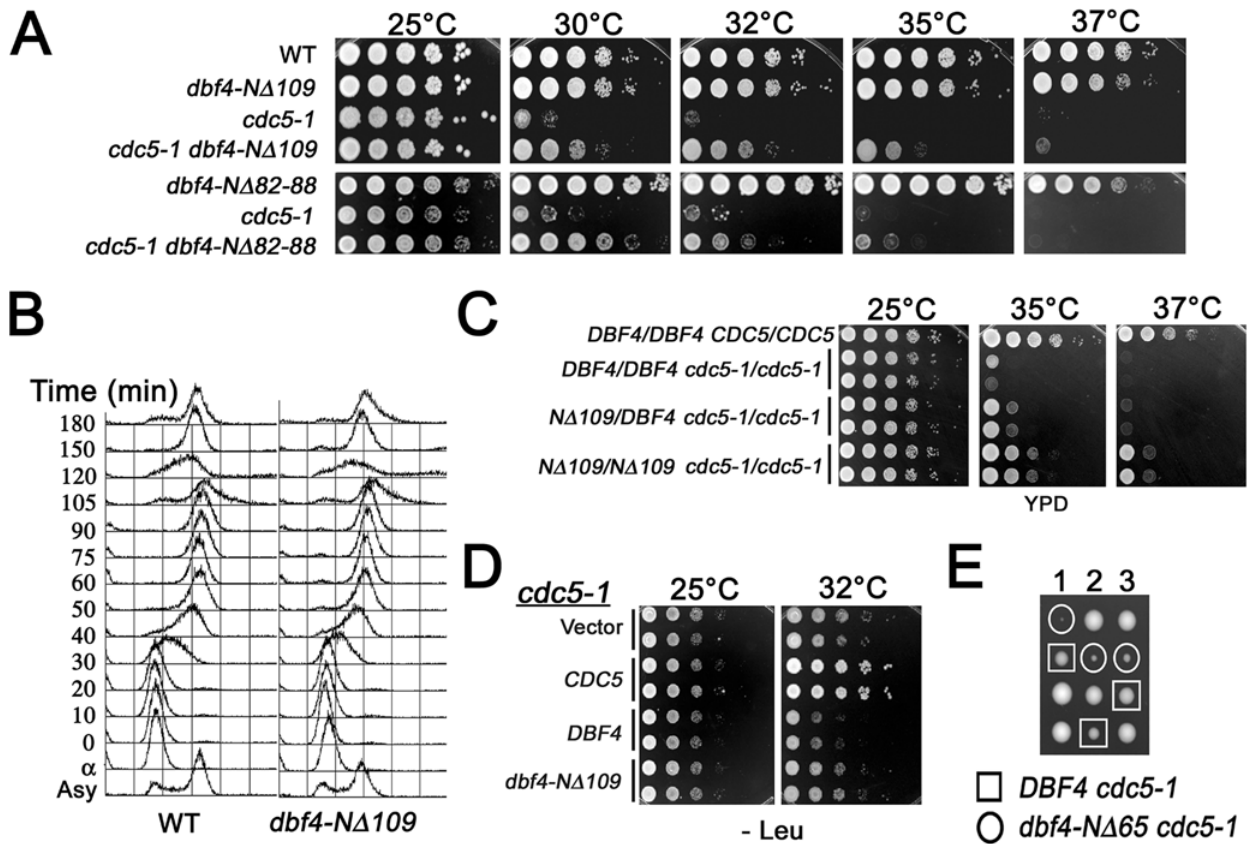
Figure 3. The Dbf4p N-terminus inhibits Polo activity. (A) dbf4-N D 109 rescues the cdc5-1 temperature sensitivity. Indicated strains were spotted at ten-fold serial dilution on YPD and grown at increasing temperatures. (B) Cell cycle progression of wild type and dbf4-N D 109 at 30 u C by flow cytometry of alpha-factor arrested (t=0) and released cells (t=10 to 180 mins). (C) The indicated diploid strains were spotted at increasing temperatures (D) DBF4 cdc5-1 was transformed with the indicated ARS CEN plasmids and spotted at 25 u C and 32 u C (E) Representative tetrads from a dbf4-N D 65 (M2007) cross to cdc5-1 (M1614).